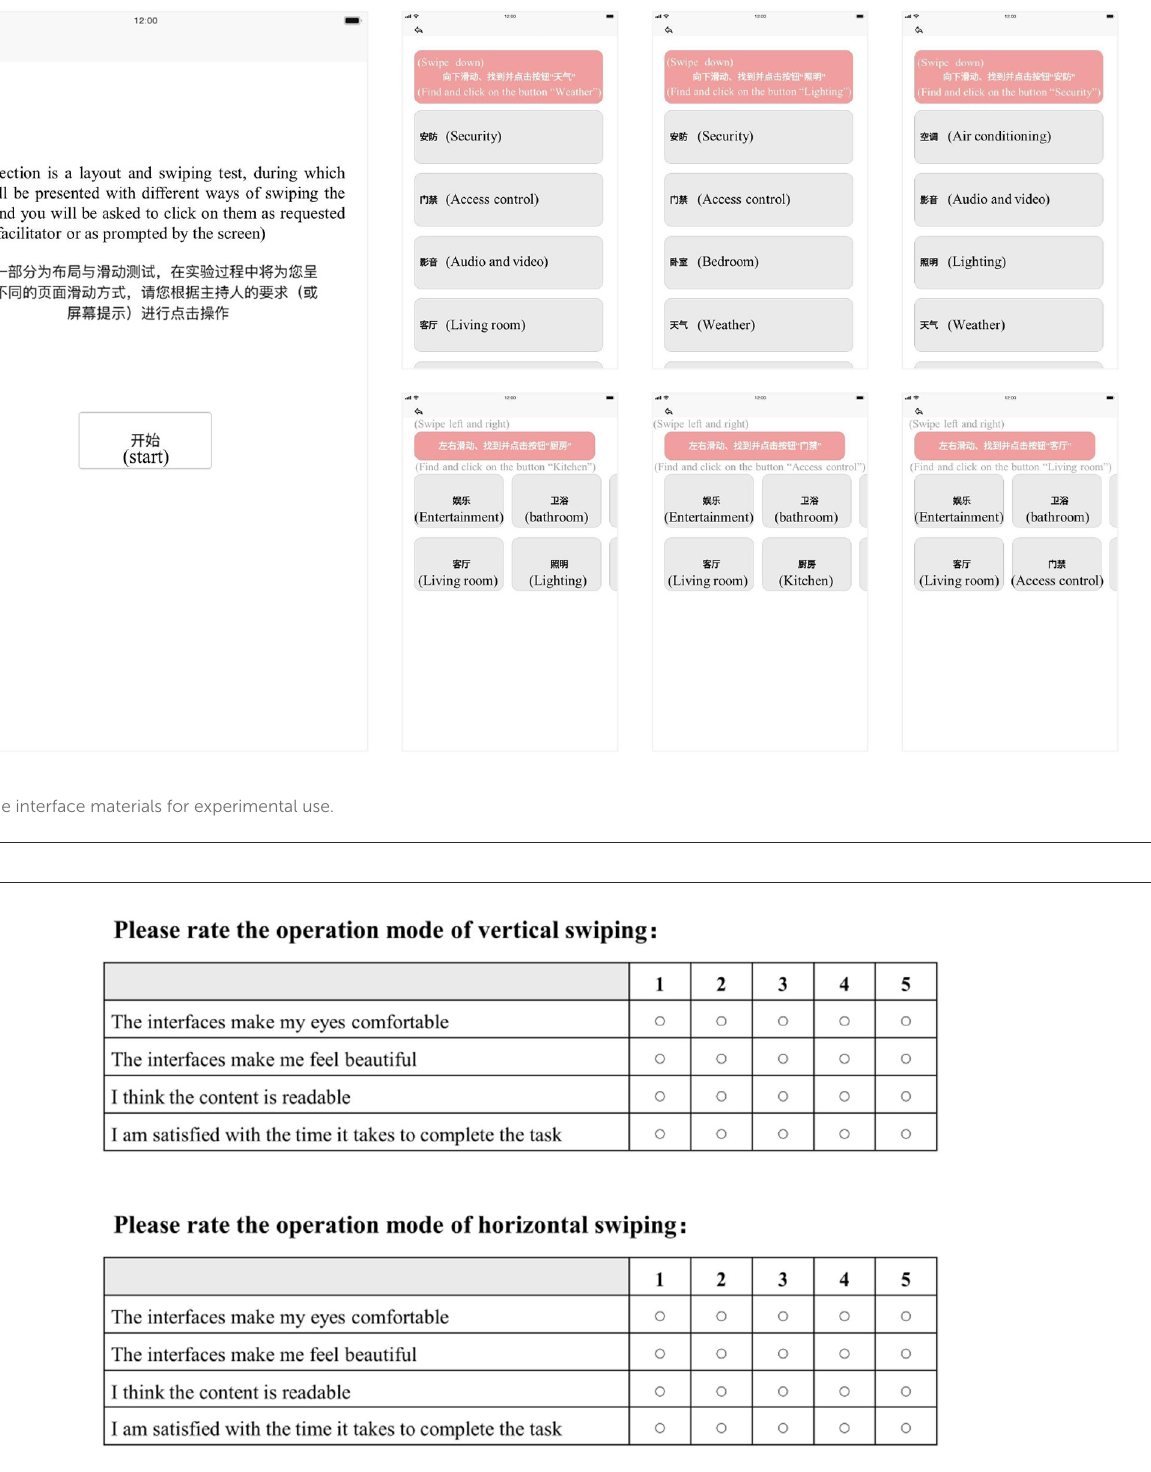
FIGURE2 The subjective preference questionnaire used in the